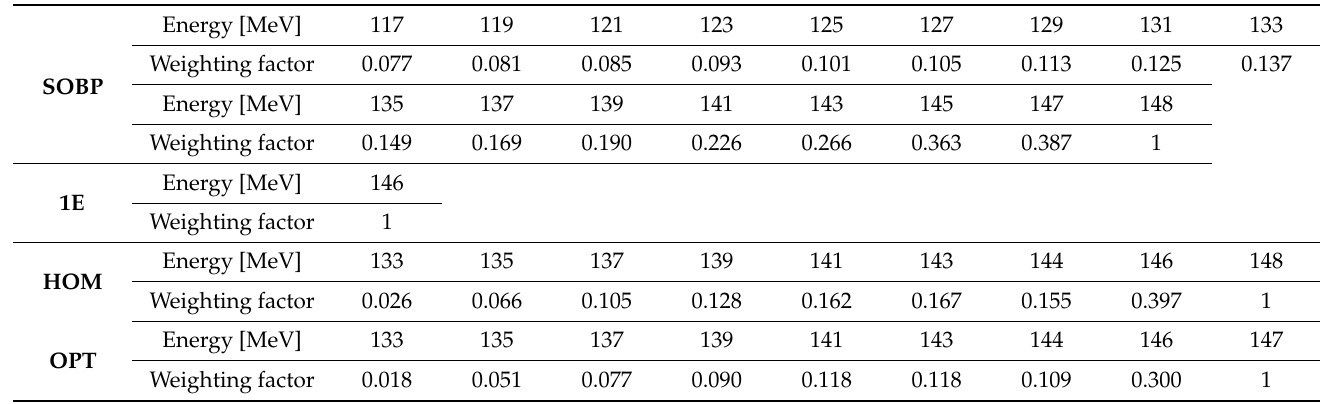
In addition, for each of the four depth-dose distributions, an optimized